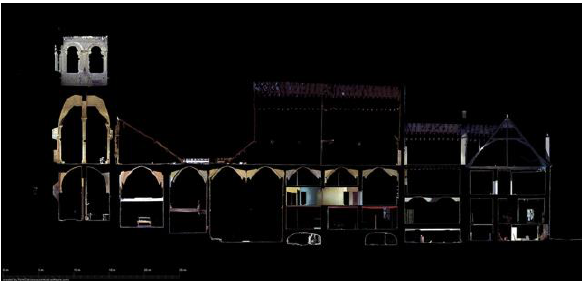
Figure 5. Section north-south with tower, refectory and kitchen